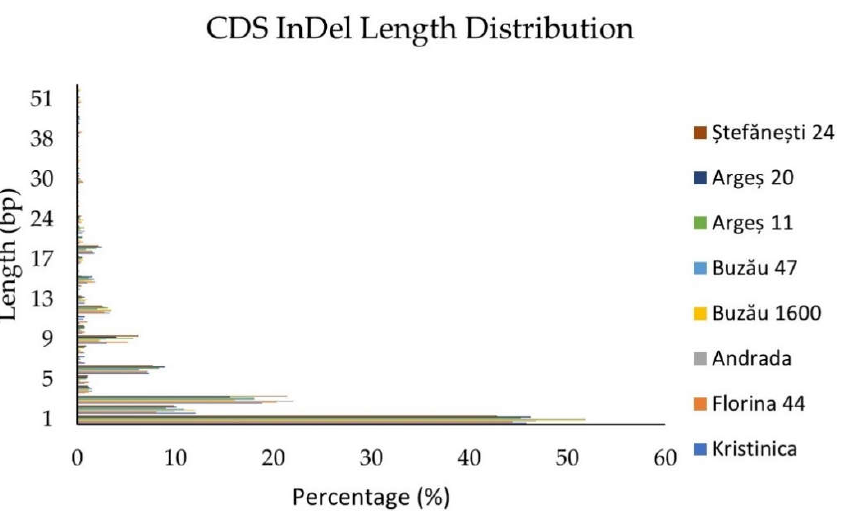
Figure 2. InDels distribution within the coding sequence.